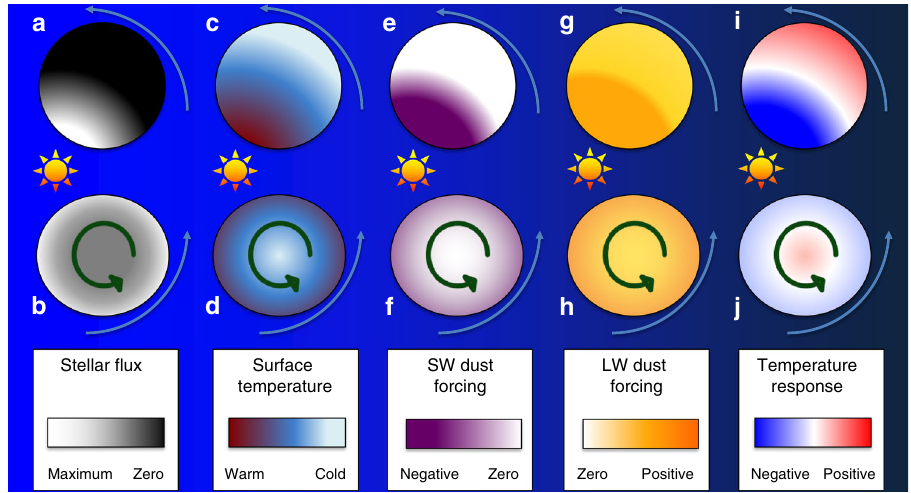
Fig. 1 Schematic showing the effect dust has on the climate of planets. For a tidally locked planet ( a ) and non-tidally locked planet ( b ), panels a – d show the base state of the planets, e – h show the short- (stellar) and long-wave (infra-red) forcing (change in surface energy balance) introduced by dust and i – j show the resultant effect of the forcing on the surface temperature. Blue arrows show the motion of the planet around the star, and green arrows show the rotation of the planet relative to the star.